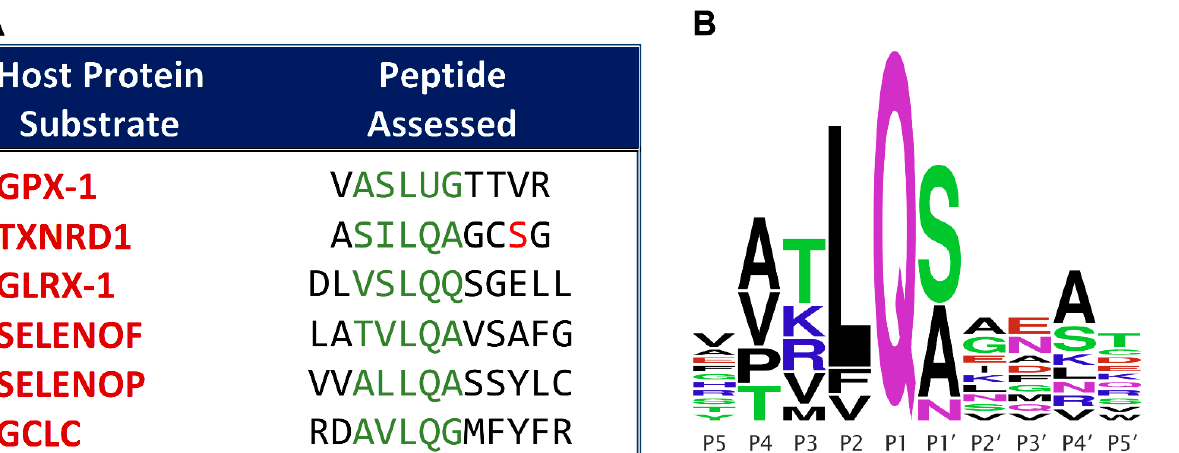
Figure 1. (A) Synthetic peptides used for M pro cleavage assessment of previously predicted sites from the host proteins listed [27]. The letters shown in green correspond to the P4 through P1 ′ positions that are most important for recognition by the enzyme. The red S in TXNRD1 is mutated from a selenocysteine in the wild type protein. (B) Consensus sequence logo for known SARS- CoV-2 M pro cleavage sites in viral nonstructural proteins . Cleavage occurs between the conserved glutamine (Q) in the P1 position and the adjacent residue in the P1 ′ position. The letters stacked vertically in a given position (representing amino acid residues in single letter protein code) show the natural variation tolerated by the protease active site in that position. Simplified from Figure 1 in [27].